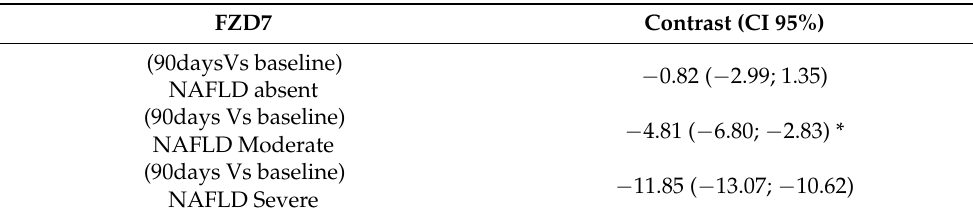
Table 3. Repeated measures analysis of variance. Contrast of FZD7 expression between NAFLD severity and time exosomes extracted from plasma of healthy subjects and NAFLD-affected patients. NutriAtt Trial, Castellana Grotte, 2015–2016. Number of healthy subjects (NAFLD absent) = 20, number of patients affected by moderate steatosis (NAFLD moderate) = 38, and severe steatosis (NAFLD Severe) = 57. * p = 0.005.